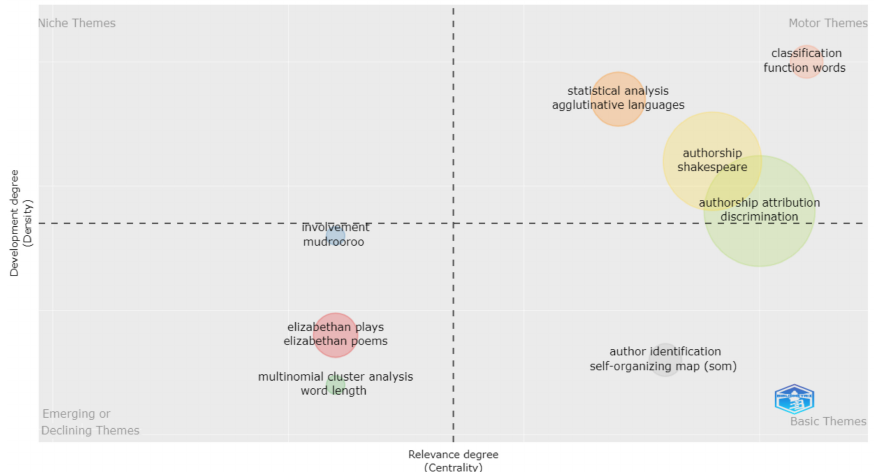
Figure 11. Thematic map for Period 2 (1992–2006) (this map was generated by